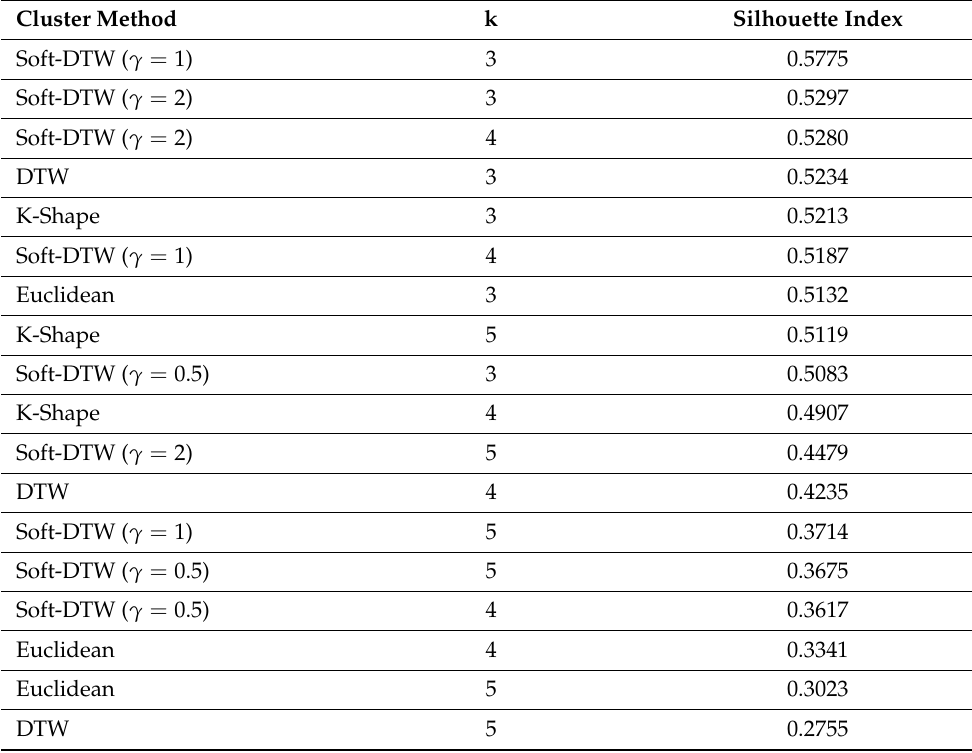
Table 1. Silhouette coefficient results for the clustering methodologies analysed. High value indicates that the object is well matched to its own cluster.